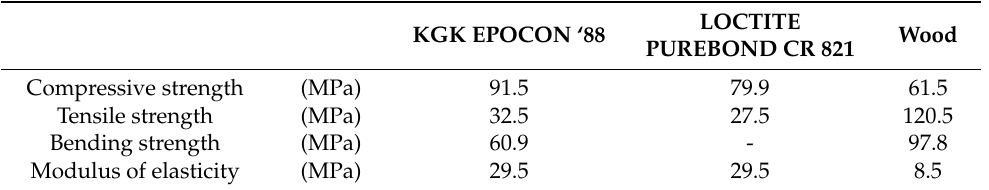
Table 2. Nominal mechanical properties for KGK EPOCON ‘88 (two-component epoxy), LOCTITE PUREBOND CR 821 (two-component polyurethane) and Siberian larch wood ( Larix sibirica ). LOCTITE KGK EPOCON ‘88 PUREBOND CR 821